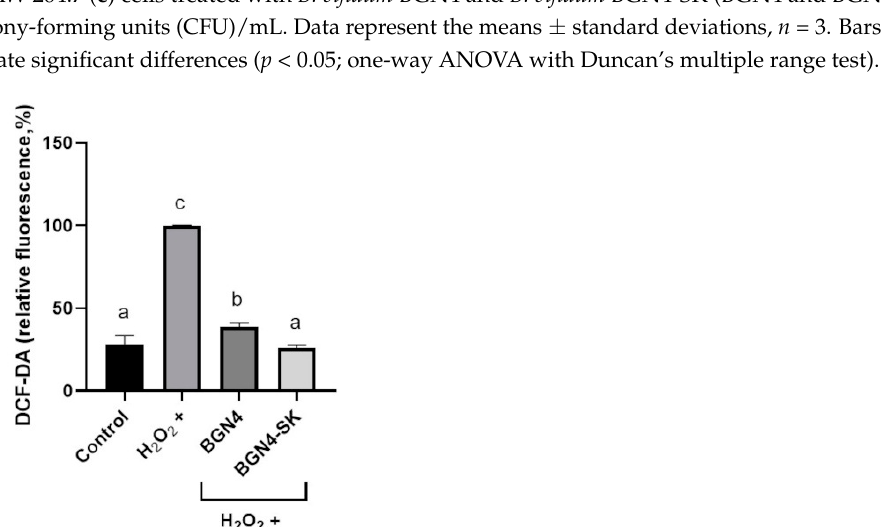
Figure 6. Intracellular reactive oxygen species (ROS) generation in H 2 O 2 -stimulated HT-29 cells treated with BGN4 and BGN4-SK at 5 × 10 8 CFU/mL. Data represent the means ± standard devia- tions, n = 3. Bars with different small letters indicate significant differences ( p < 0.05;